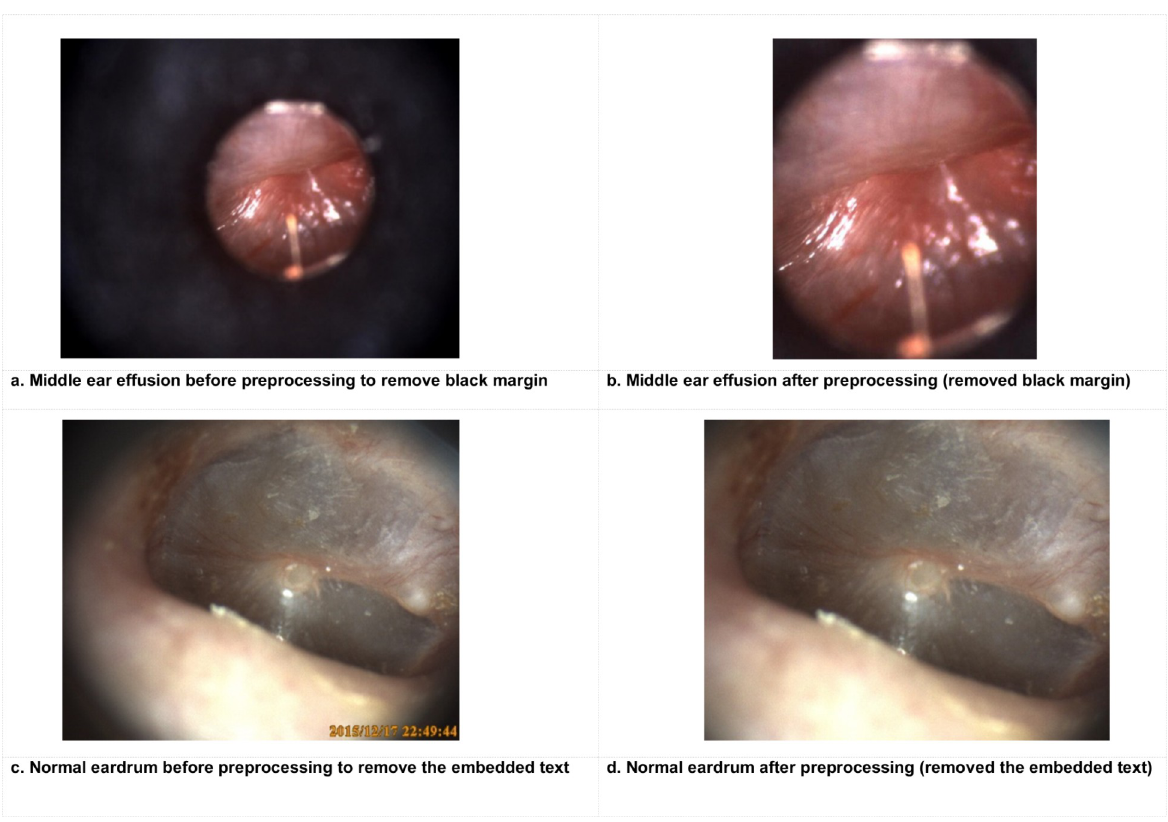
Fig 3. Example of before (a, c) and after (b, d) preprocessing to remove black margin and embedded time